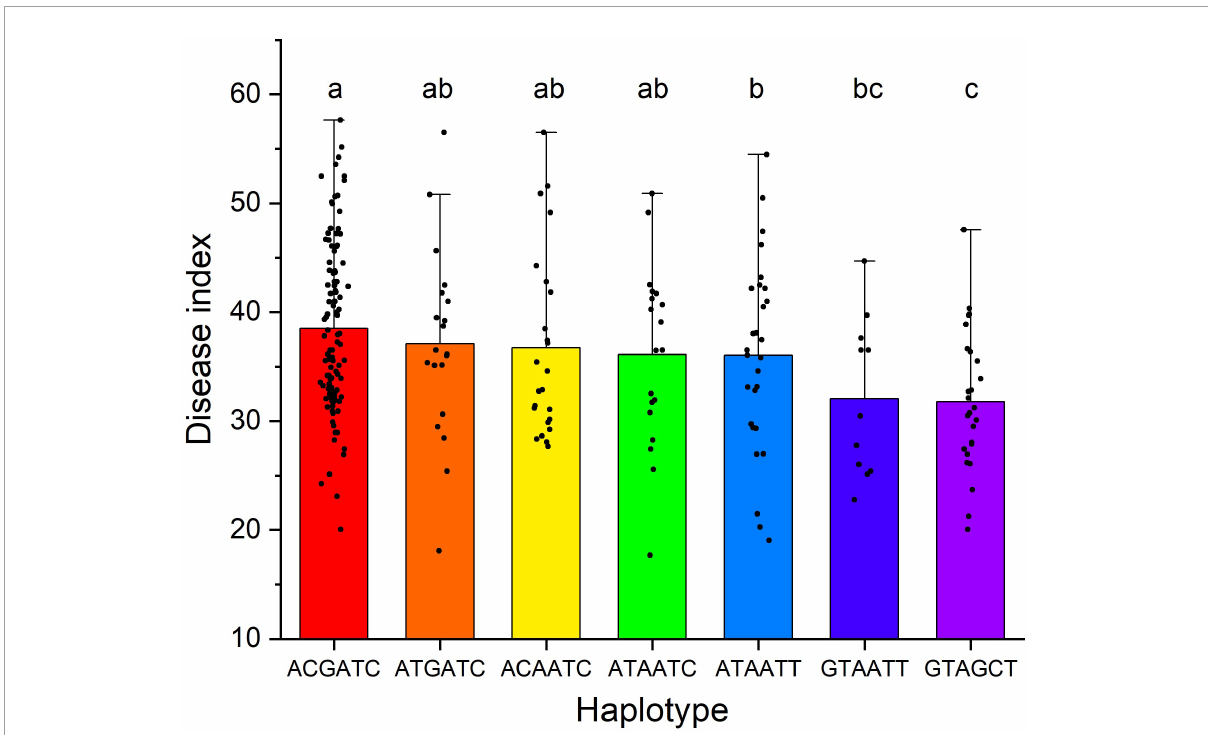
FIGURE5 Haplotype analysis based on single nucleotide polymorphisms significantly associated with Fusarium crown rot (FCR) resistance. The different lowercase letters between haplotypes denote FCR resistance were significant ( P < 0.05) differences. The seven haplotypes from left to right contained 0, 1, 1, 2, 3, 4, and 6 resistance alleles and presented 107, 20, 24, 19, 28, 11, and 26 accessions, respectively.